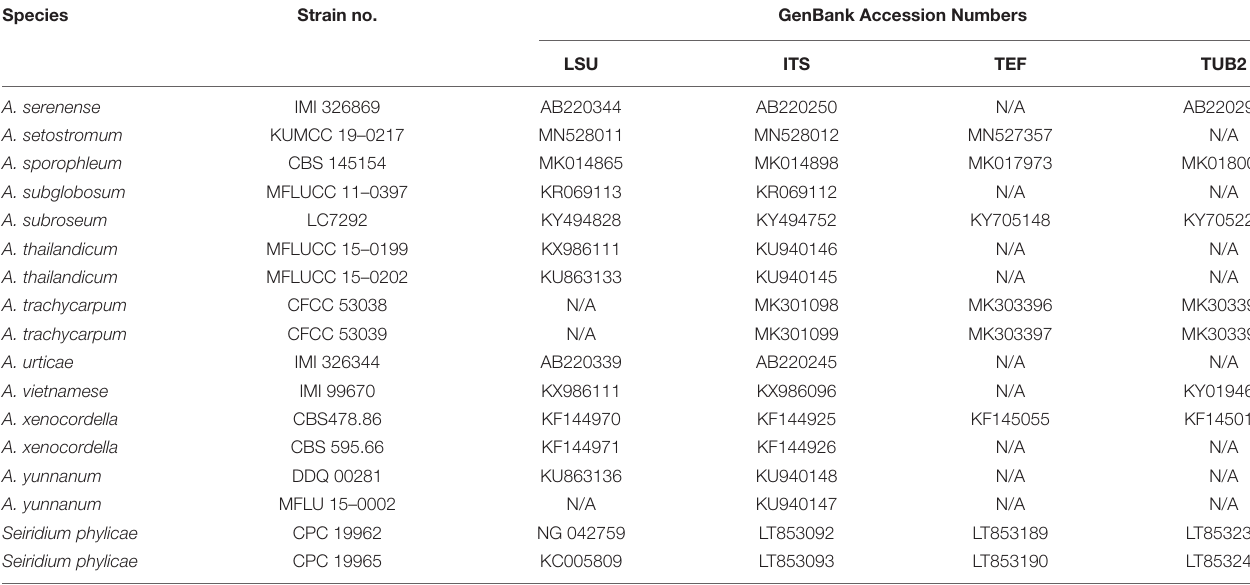
eye. Sexual morph: Stromata scattered to gregarious, immersed to erumpent, later becoming superficial, dark brown to black, fusiform, forming a slit-like opening at the apex, multi-loculate, membranous, with a periphysate ostiole. Ascomata 122–153 µ m high, 138–207 µ m diam, arranged in rows, dark brown to black. brown to hyaline cells of textura angularis . Hamathecium